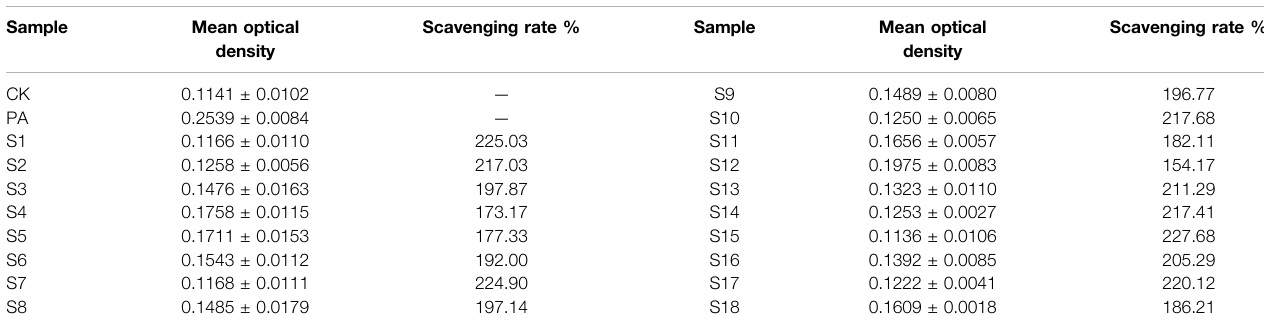
TABLE 3 | ROS inhibition rates of 18 batches of BBTD extracts (mean ± SD, n = 3).